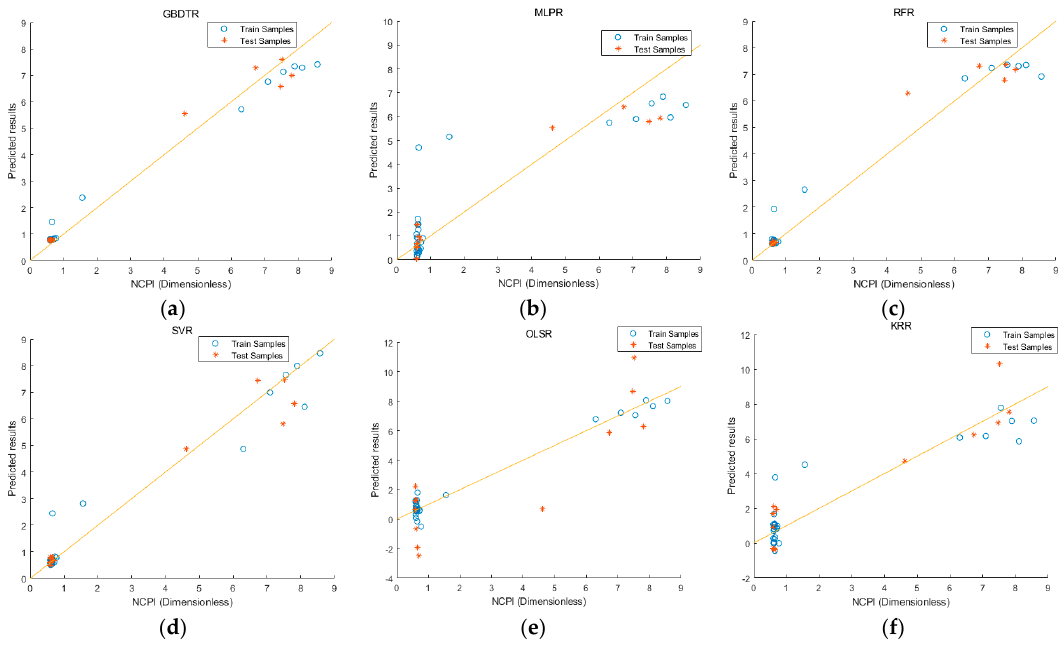
Figure 9. The scatter plots for the estimated and in-situ values in Shahu Port. ( a ) GBDTR; ( b ) MLPR; ( c ) RFR; ( d ) SVR; ( e ) OLSR; ( f ) KRR. Table 2. of the retrieval results of the di ff erent regression models for the Shahu Port